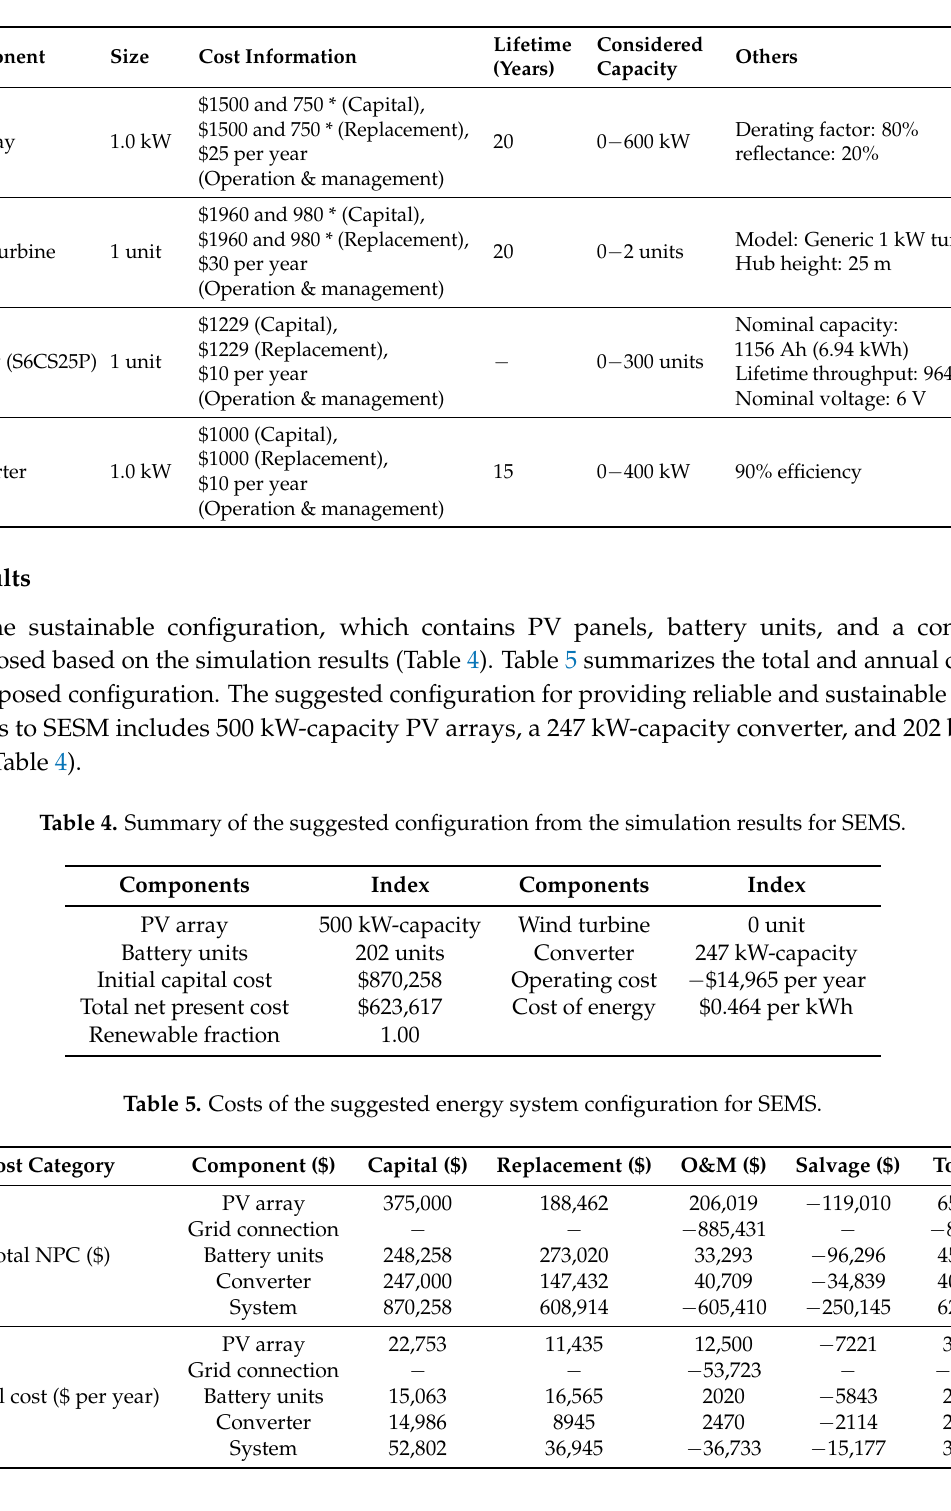
Table 3. Economic information about the components (* The supporting policies and plans by the South Korean government are applied).